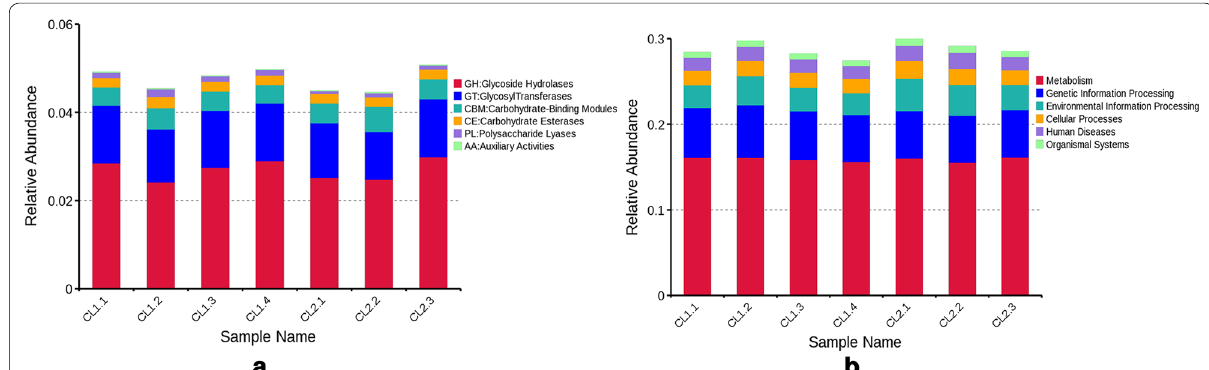
Fig. 4 The relative abundance of functionally annotated genes at level 1 a based on the CAZy database and b based on the KEGG database. The vertical axis represents the relative proportion of comments to a functional class. The horizontal axis represents the sample name. The functional categories corresponding to each color block are shown in the figure on the right